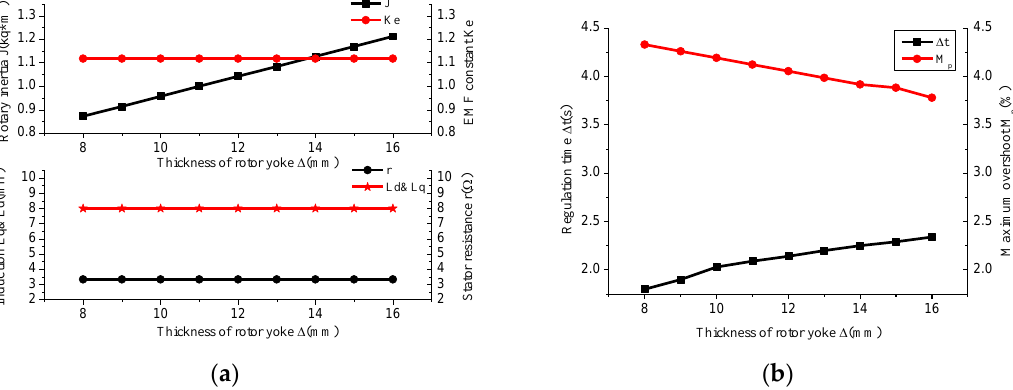
Figure 10. Influence of rotor yoke thickness: ( a ) Model variables; ( b ) Dynamic characteristic response.